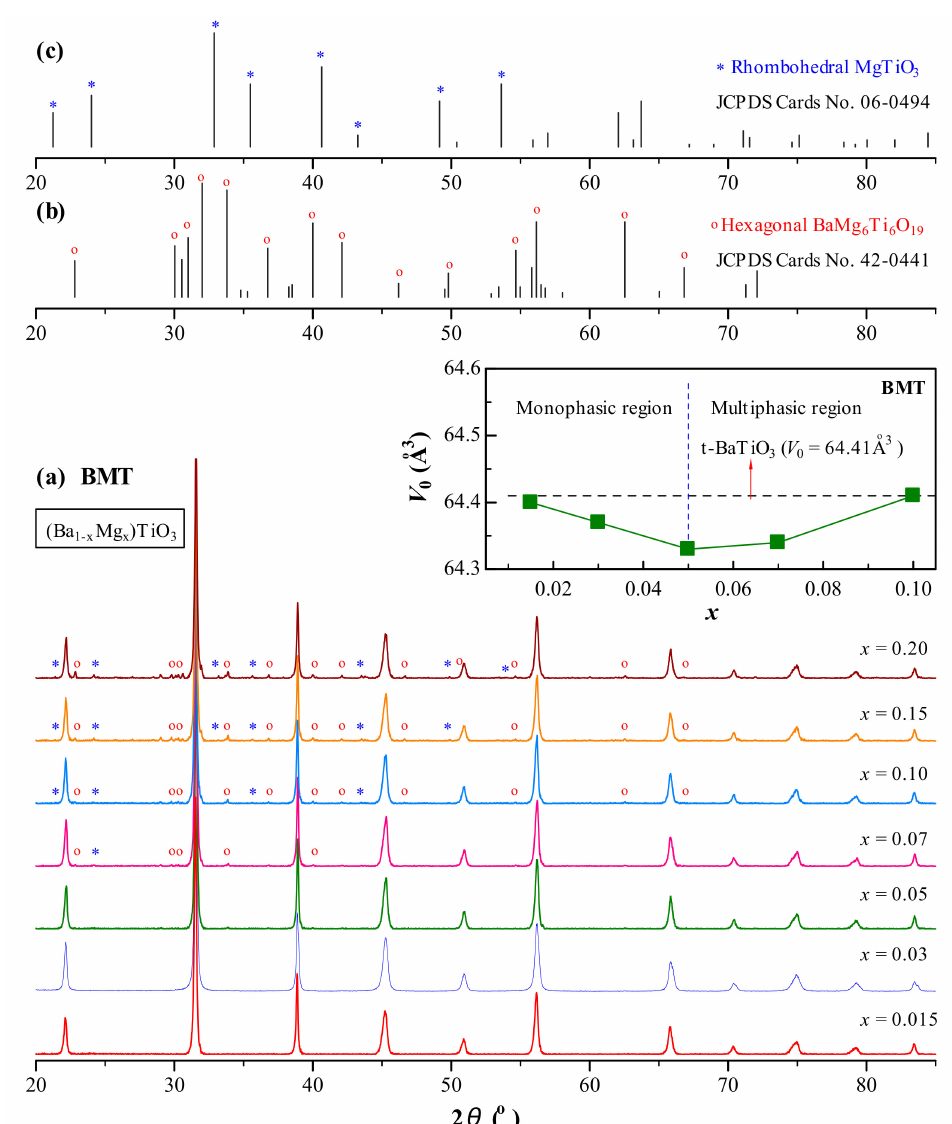
Figure 3. XRD patterns of ( a ) (Ba 1 − x Mg x )TiO 3 ( x = 0.03-0.20) (BMT) ceramics sintered at T s = 1200 ◦ C. Inset depicts variation in V 0 as a function of x . Simulated XRD patterns of ( b ) hexagonal BaMg 6 Ti 6 O 19 (JCPDS Cards No. 42-0441) and ( c ) rhombohedral MgTiO 3 (JCPDS Cards No.